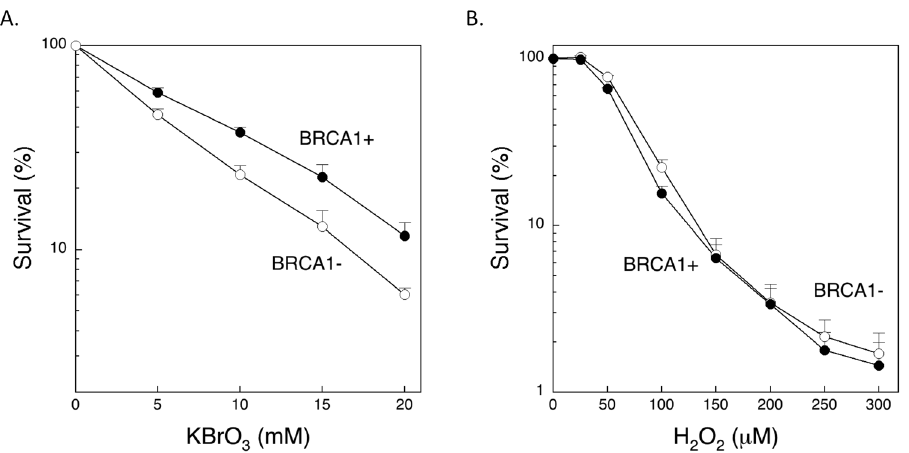
Figure 1. Characterization of sensitivity to oxidative DNA damage in human BRCA1 cell lines. Experiments were conducted as described under ‘‘Materials and Methods’’. Human BRCA1 positive ( + ) and negative ( 2 ) cells were treated with A. KBrO 3 or B. H 2 O 2 for 1 h as indicated, and cell survival was measured by growth inhibition assay.